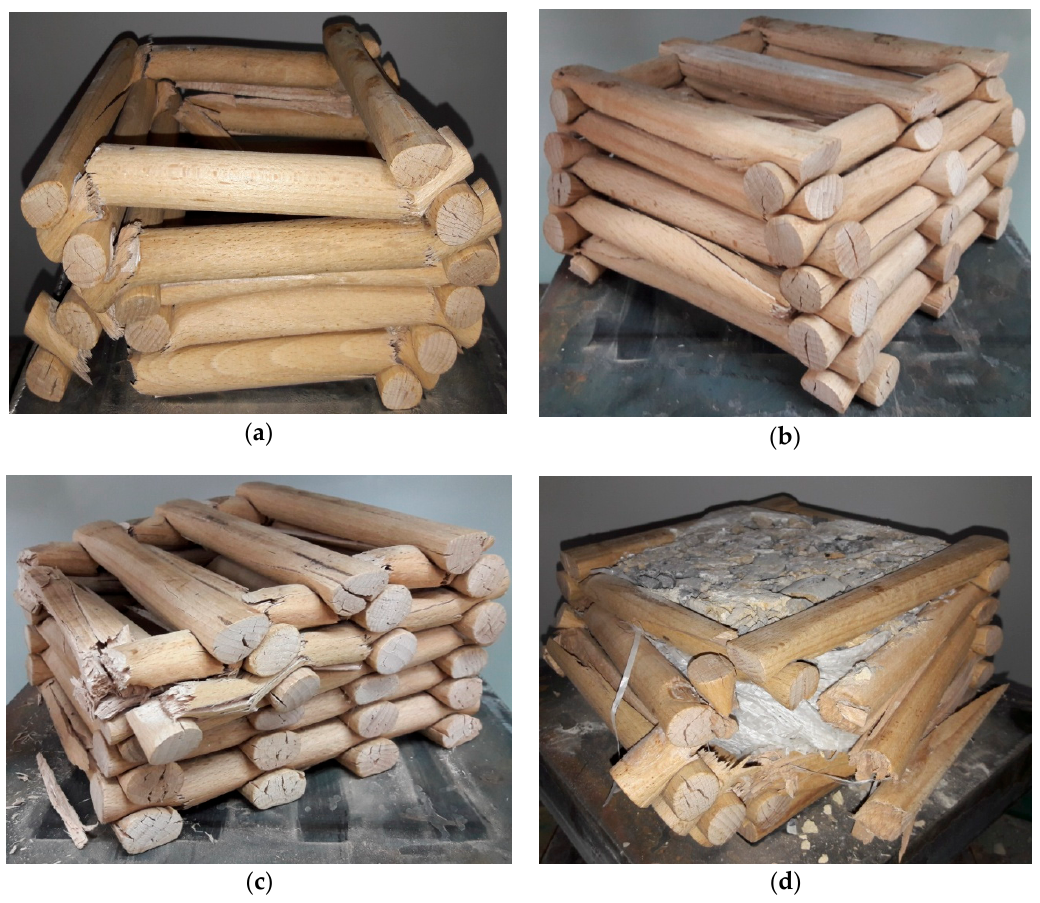
Figure 8. Models of the wooden cribs after compression tests: ( a ) Four-point; ( b ) Six-point; ( c ) Eight-point; ( d ) Four-point filled with waste rocks.